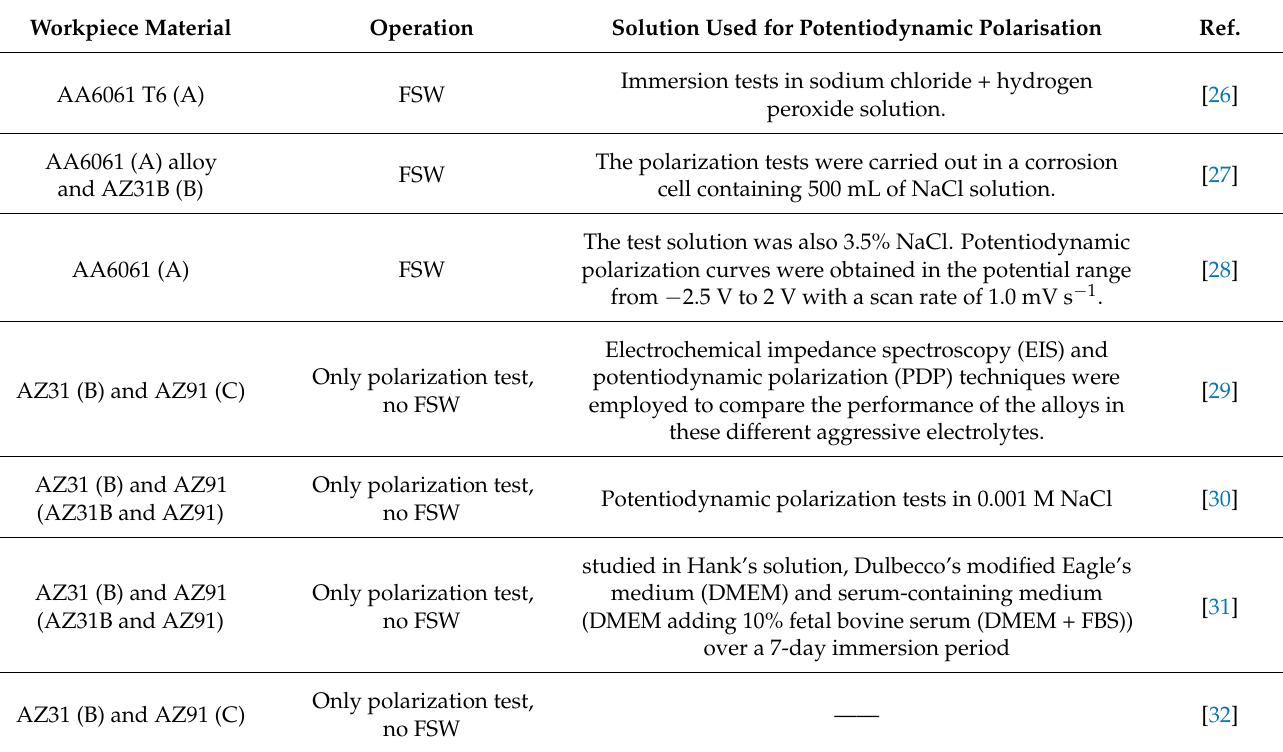
Table 2. Potentiodynamic corrosion tests of AA6061, AZ31B, and